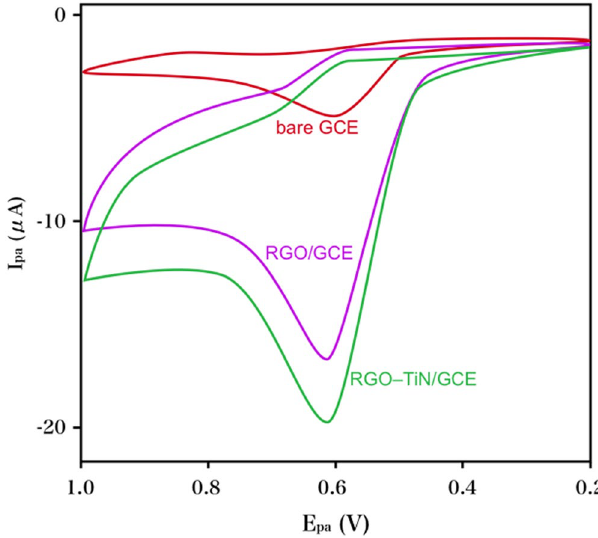
Figure 4. CV profiles of bare GCE, RGO/GCE and RGO- TiN/GCE towards NGF (0.1 mM) in PB (0.1 M) with a pH of 8.0 at a scan rate of 50 mV/s.